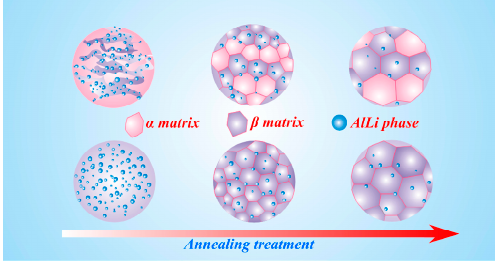
Figure 10. Flow chart of solid solution of the Mg-Li alloy.